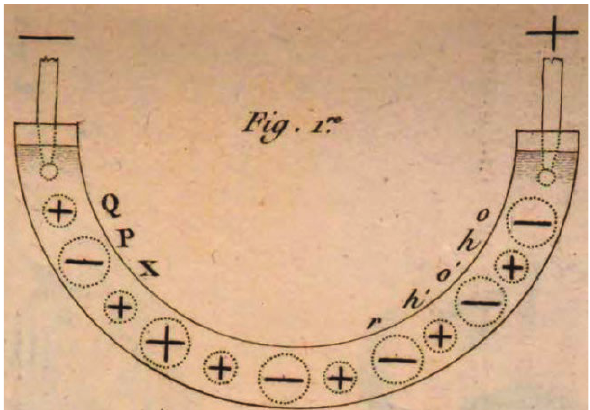
Figure 5. Schematic drawing illustrating Grotthuß´ concept of the flow of the electric current during the electrolysis of water. “ Fig.1 re ” shows a U-tube filled with water, which forms of a chain of posi- tively polarized hydrogen and negatively polarized oxygen atoms. It is important to realize that the circles with + and – signs are not ions, they are schematic depictions of the polarized atoms of the intact, neutral water molecules (which consist here from one hydrogen and one oxygen). During the complete process, free ions are not present in water. 38 For a more detailed explanation see text. Taken from ref. [67]